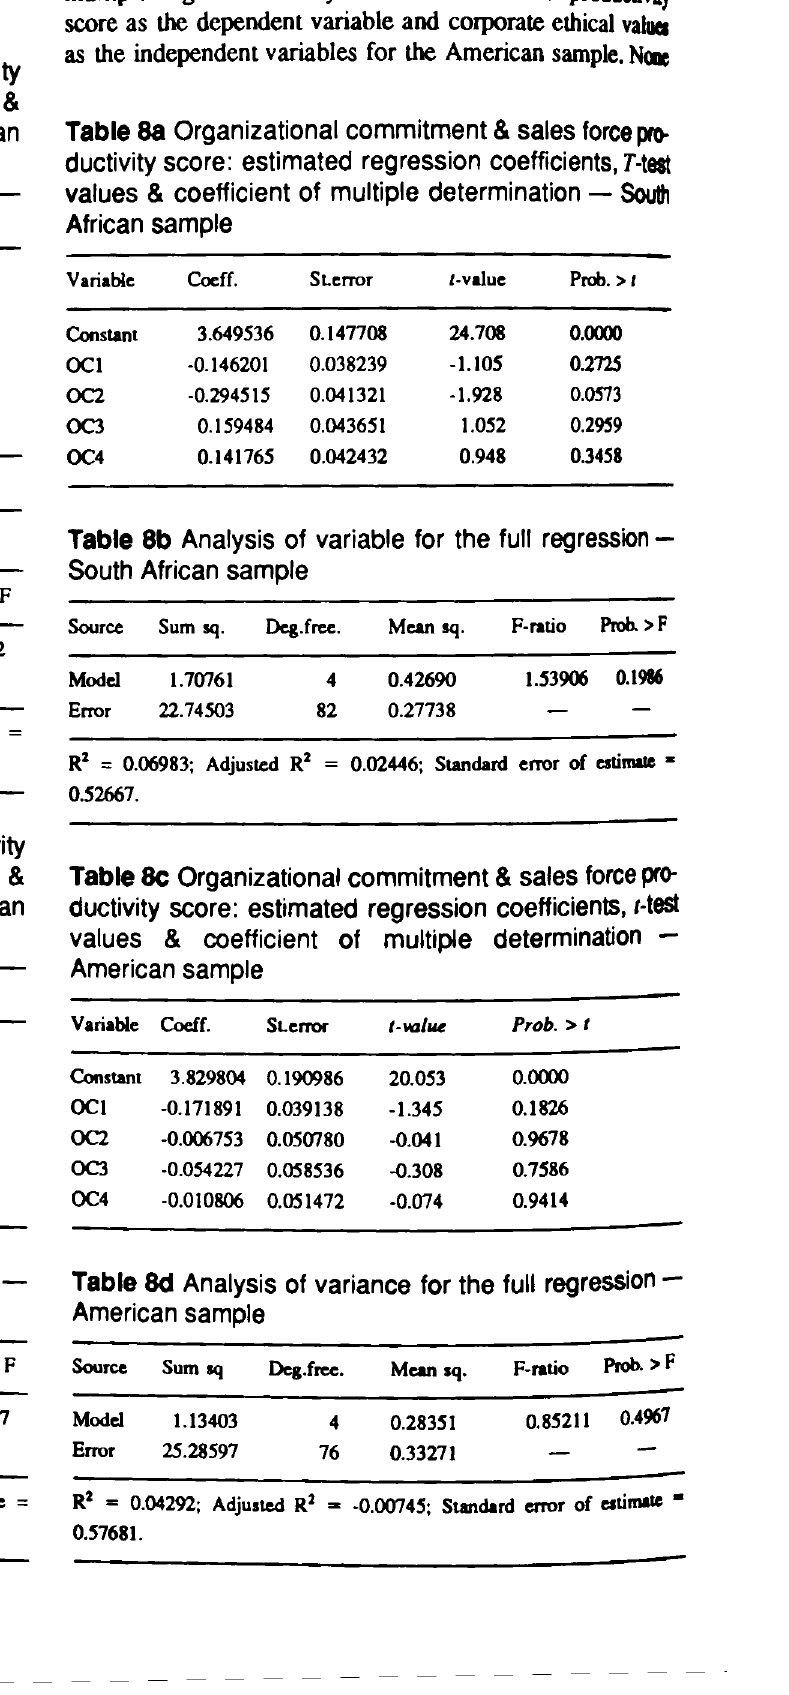
Table 7a Ethical values & sales force productivity score: estimated regression coefficients, t-test values & coefficient of multiple determination - sample